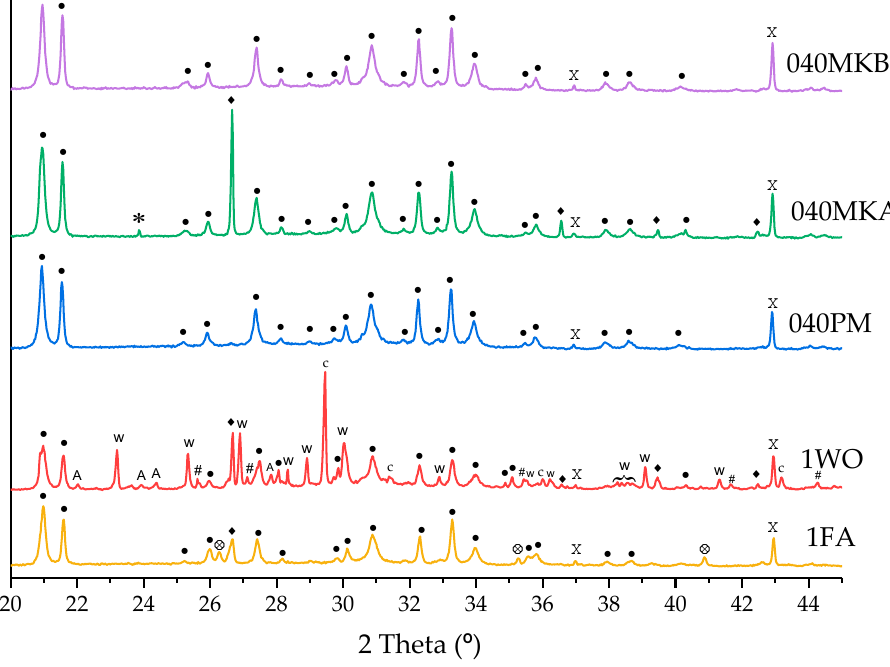
Figure 5. XRD patterns of MKPC pastes after 28 days of curing. • : K-struvite (PDF file: 01-075-1076); Figure 5. XRD pa tt erns of MKPC pastes after 28 days of curing. ● : K ‐ struvite (PDF file: 01 ‐ 075 ‐ 1076); X: MgO (PDF file: 01-087-0651); W: wollastonite (PDF file: 01-075-1396); (cid:7) : quartz (PDF file: 01- X: MgO (PDF file: 01 ‐ 087 ‐ 0651); W: wollastonite (PDF file: 01 ‐ 075 ‐ 1396); ♦ : quartz (PDF file: 01 ‐ 079 ‐ 1910); *: KH 2 PO 4 (PDF file: 00 ‐ 035 ‐ 0807); ⨂ : mullite (PDF file: 01 ‐ 083 ‐ 1881); c: calcite (PDF file: 01 ‐ 079-1910); *: KH 2 PO 4 (PDF file: 00-035-0807); ⊗ : mullite (PDF file: 01-083-1881); c: calcite (PDF file: 083 ‐ 0578); #: microcline (PDF file: 00 ‐ 022 ‐ 0675); A: albite (PDF file: 01 ‐ 076 ‐ 0927). 01-083-0578); #: microcline (PDF file: 00-022-0675); A: albite (PDF file: